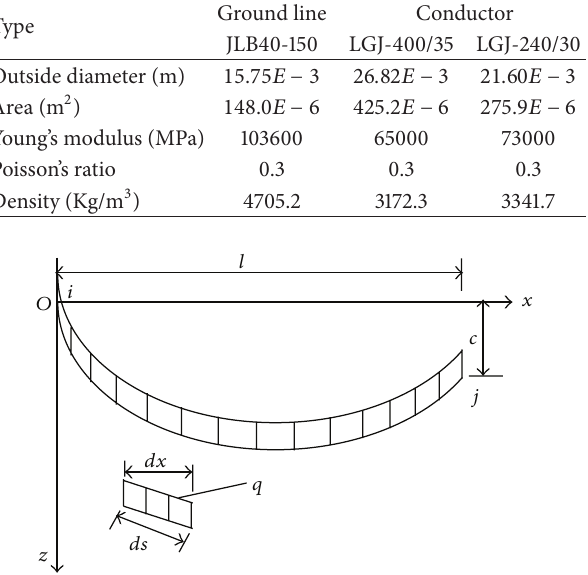
Figure 4: Coordinates of a single cable under